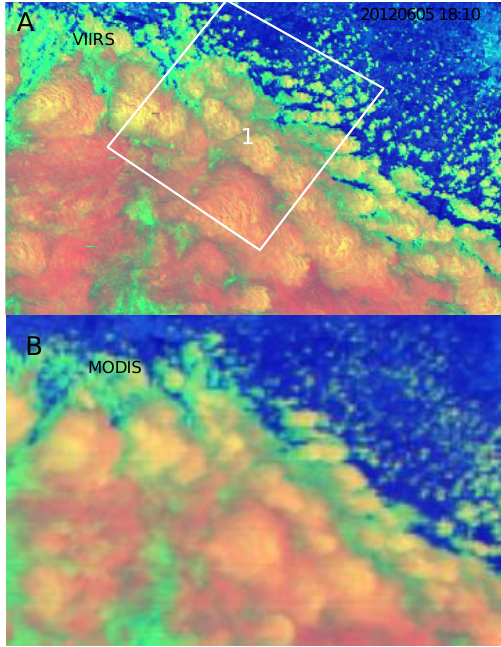
Fig. 10. Same as Fig. 1, but showing the regionally polluted clouds over the region of Buffalo, NY, USA, and to the south of Lake On- tario, as seen by VIIRS (18:10UT, panel A ) and MODIS (18:30UT, panel B ) overpasses on 5 June 2012, in an area of 160km × 113km centered at 42.74 ◦ N, 78.55 ◦ W.